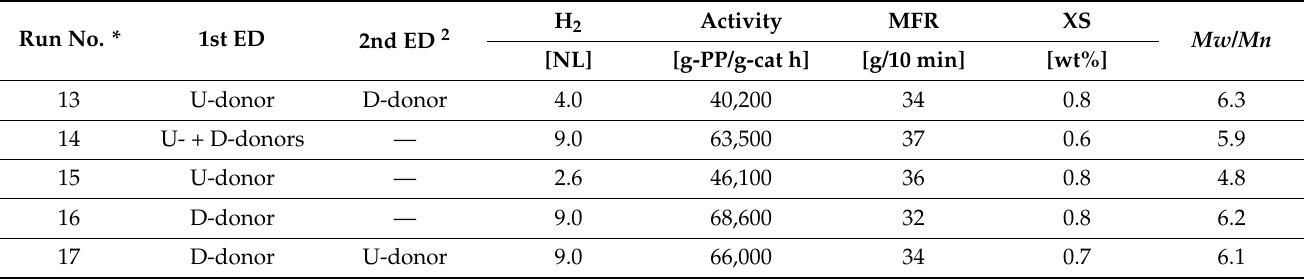
Table 3. Effect of binary use of U- and D- donor for propylene polymerization